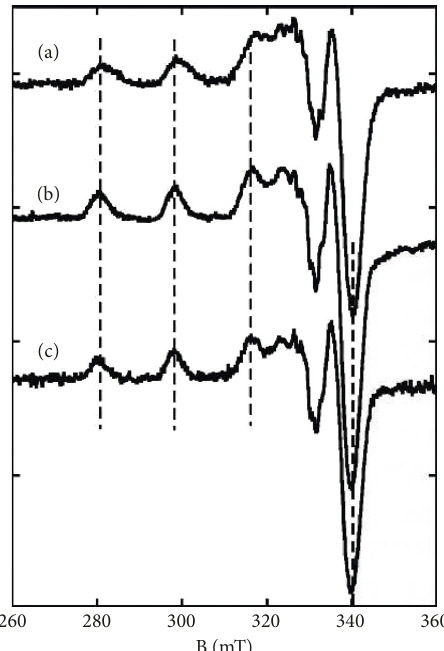
Figure 3: 9.5-GHz EPR spectra of complexes 2 (a), 3 (b), and 4 (c). Dotted lines indicate the position of the hyperfine